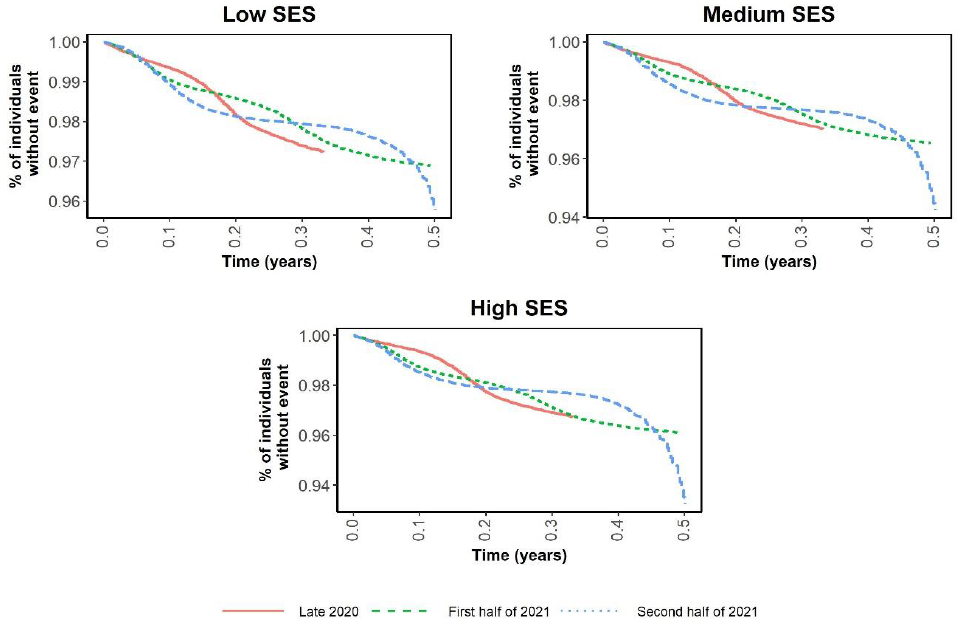
Figure 1. Kaplan–Meier curves of time to infection by socioeconomic level and period. Figure 1. Kaplan – Meier curves of time to infection by socioeconomic level and period.